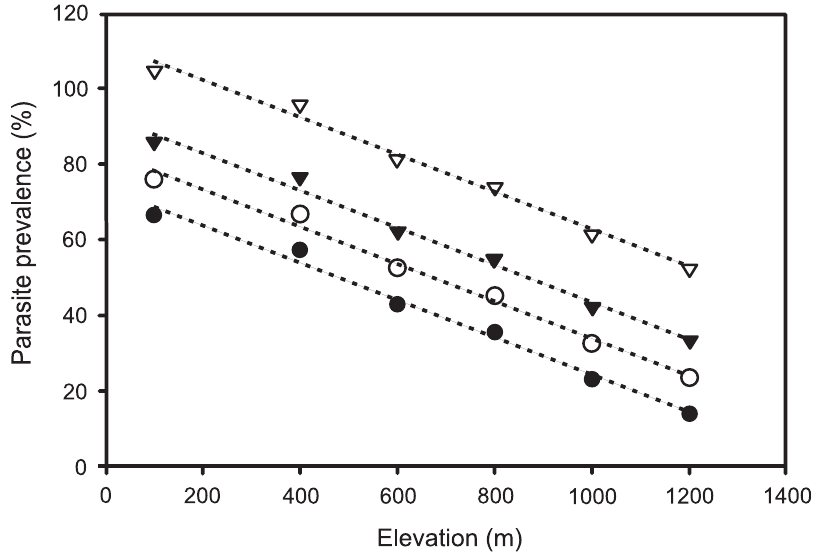
N Figure 3. Extrapolations of parasite prevalence with increments of temperature. Parasite prevalence along the elevational gradient with ), 1 u C ( # ), 2 u C ( m ) and 4 u C ( D ), using the equation of the linear regression between overall parasite prevalence and mean annual increments of 0 u C ( temperature (temperature –140.62/0.1047= parasite prevalence). Extrapolations indicated that there will be an increase of about 10% in the prevalence of parasites for each 1 u C of increment in temperature.